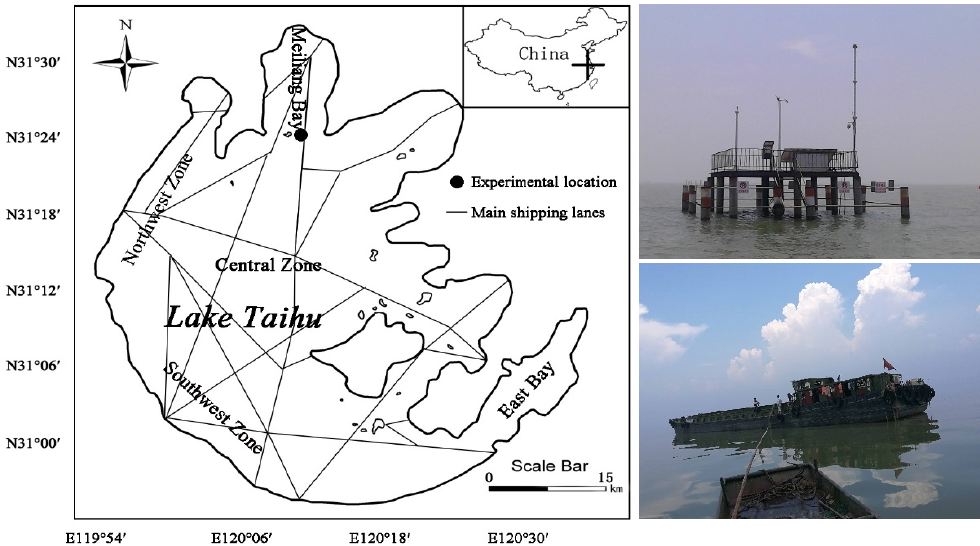
Figure 1. Experimental location, platform, and the chartered ship.